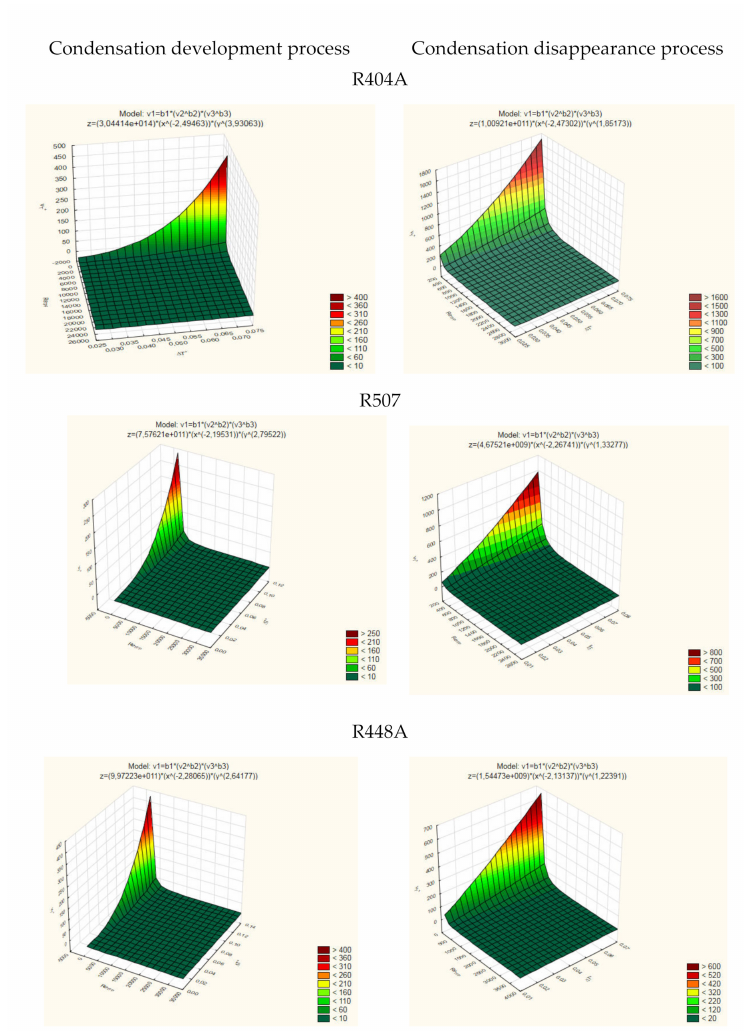
Figure 7. Relationship between the dimensionless velocity, v + parameters from Equation (2) for the process of condensation of the investigated refrigerants, the calculations made with Statistica software.